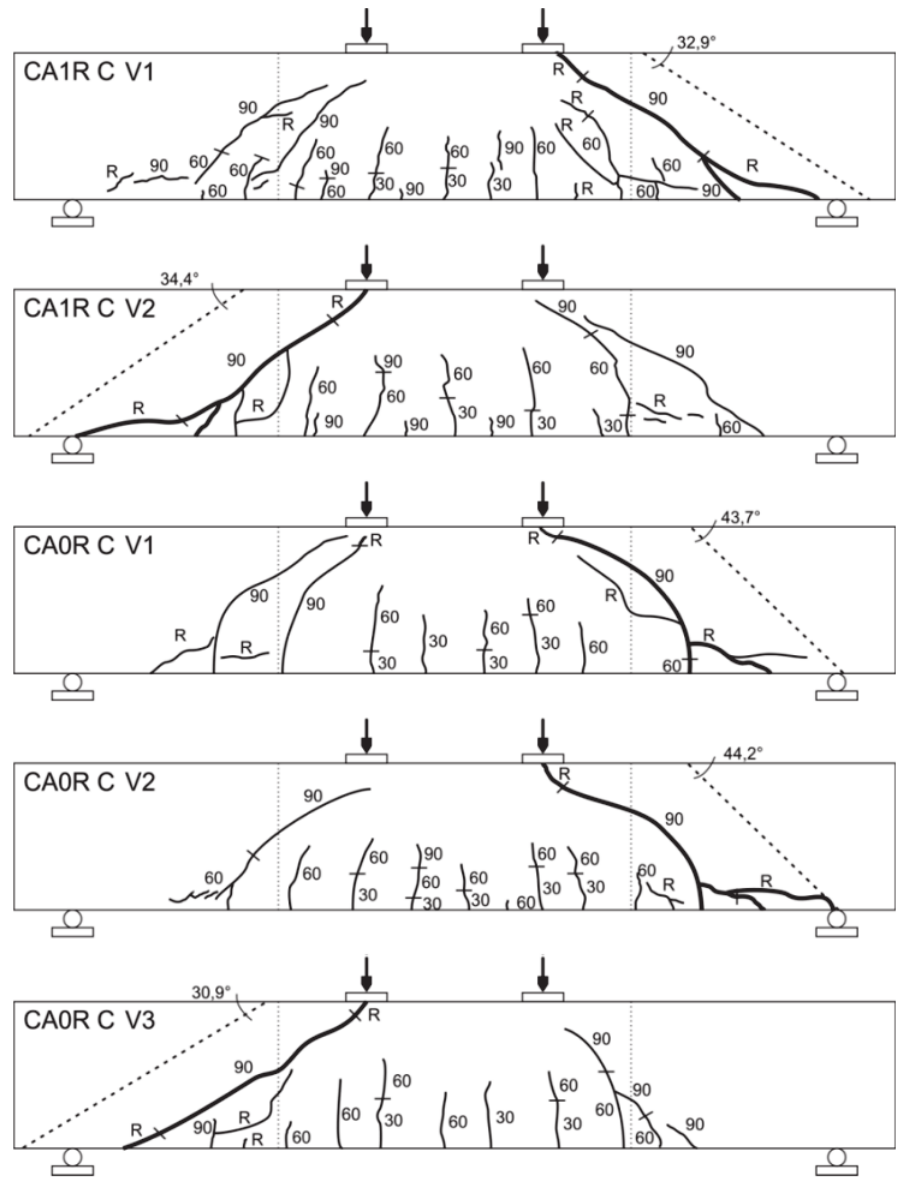
Crack patterns of self consolidating concrete beams with reduced amount of coarse